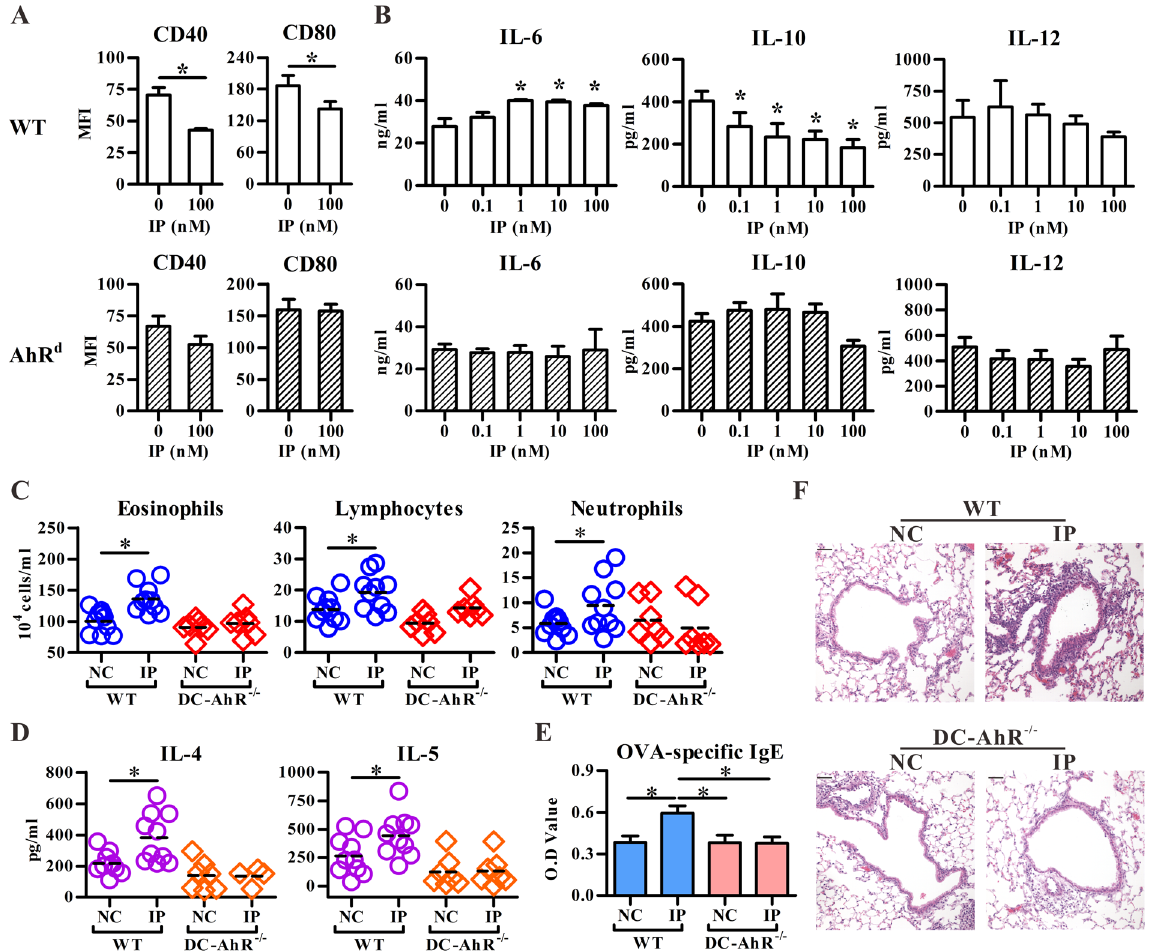
Figure 5. Indeno[1,2,3-cd]pyrene (IP) modulates DC function and allergic lung inflammation in an AhR- dependent manner. Bone marrow cells from C57BL/6 and AhR d mice were treated with IP starting from day 1 to day 8, and LPS was added for another 24 hrs. The BM-DCs were harvested for phenotypic analysis ( A ) and the levels of cytokines in the culture supernatants were measured by ELISA ( B ). Data shows mean ± SD of three independent experiments. C57BL/6 (WT) or DC specific AhR-null mice (DC-AhR − / − ) were intranasally pre-exposed to vehicle (NC) or IP (2 μ M) and then immunized with OVA. All mice were challenged with OVA aerosol for three consecutive days. Cell subsets ( C ) and cytokine levels ( D ) in BALFs were both determined by flow cytometry. The line within the vertical points marks the mean for each group. ( E ) Serum levels (mean ± SEM) of OVA-specific IgE Abs were measured by ELISA. n = 7–10/group. ( F ) Representative lung sections stained with hematoxylin and eosin. The magnification: 200 × . * P < 0.05 vs. control (Mann-Whitney U test). Scale bars represent 50 µ m in ( F ).